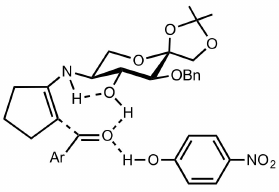
Figure 36. The proposed transition state of the aldol reaction catalysed by 513 and p